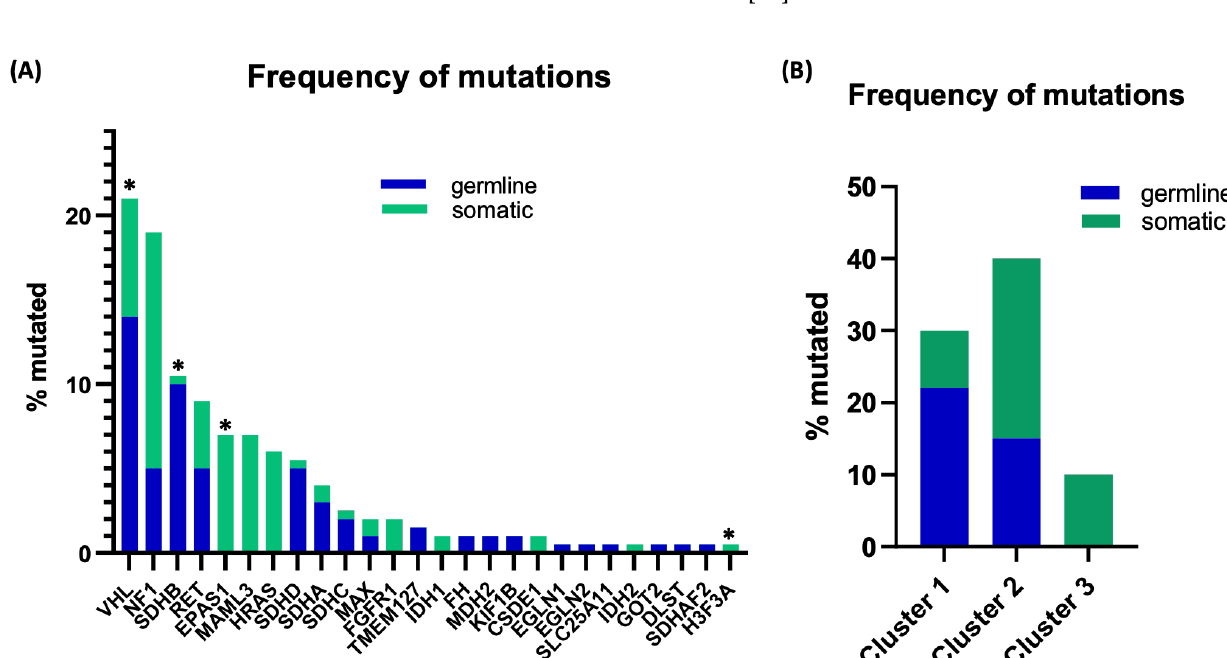
Figure 1. Approximate mutation frequency of genes implicated in PPGLs with a known genetic driver. Data were compiled from published series [10,14,16–18] and our own cohort regardless of age groups and may reflect referral bias. ( A ) Mutation distribution based on individual genes and ( B ) cluster type. Tumors with unknown genetic drivers are not shown. For the purpose of this representation, mutation frequencies of uncommon genes have been depicted as 0.5%. * genes that can be post-zygotically mutated. The genes implicated in PPGLs, with various degrees of supporting evidence are: NF1, VHL, RET, SDHA, SDHB, SDHC, SDHD, SDHAF2, TMEM127, MAX, EPAS1, HRAS, FH, EGLN1, EGLN2, MDH2, FGFR1,